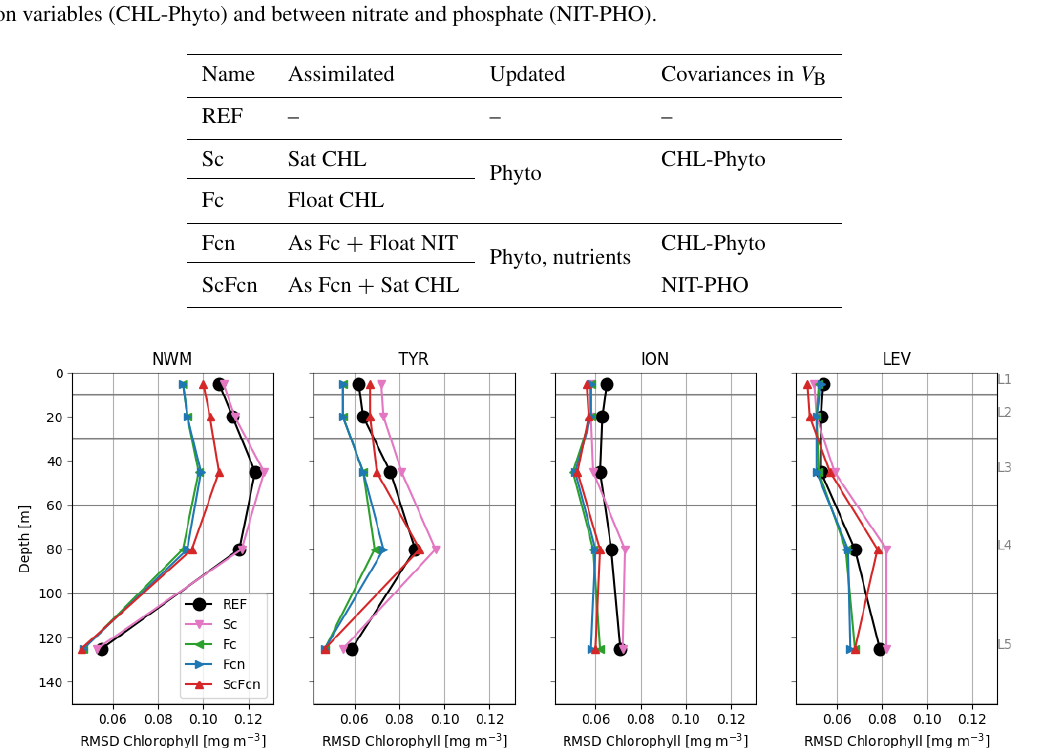
Table 1. Assimilation set-ups and names assigned to the simulations. Assimilated variables can be satellite chlorophyll (Sat CHL), float chlorophyll (Float CHL), and float nitrate (Float NIT). DA updates can be applied to the 17 phytoplankton variables (phyto) and to nitrate and phosphate concentrations (nutrients). The covariance between biogeochemical variables applied by V B is that between chlorophyll and